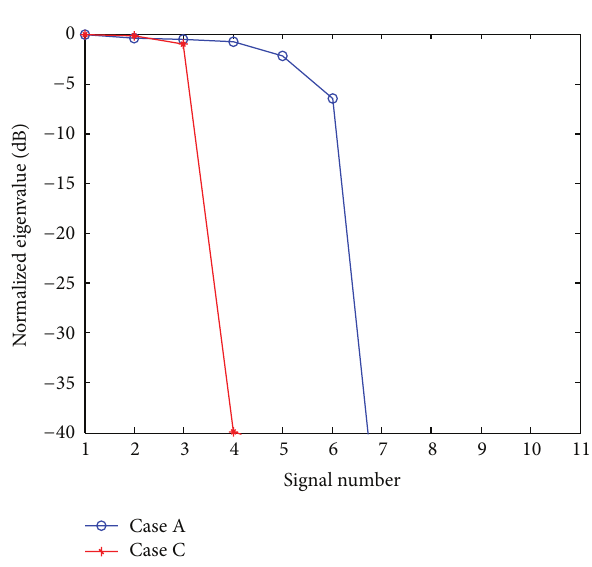
Figure 4: Normalized eigenvalues in the case of A and C, from the first step